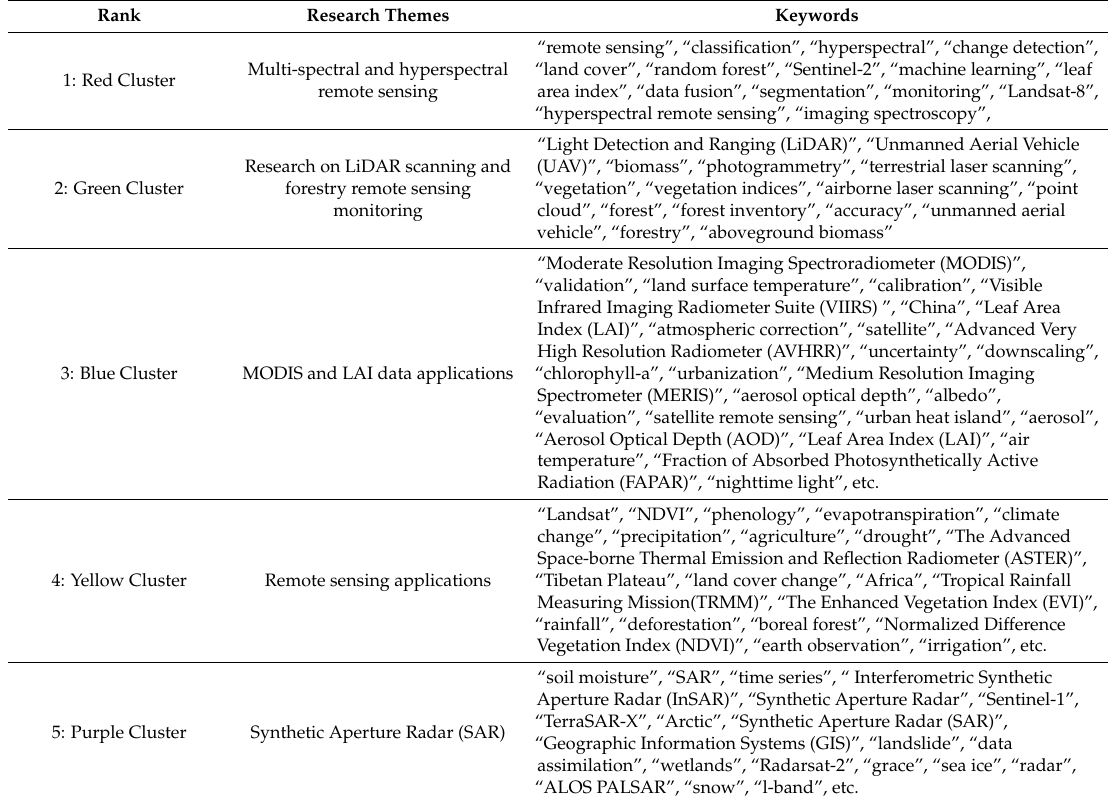
Table 10. The cluster of Remote Sensing Open Access Journal (RS OAJ) research